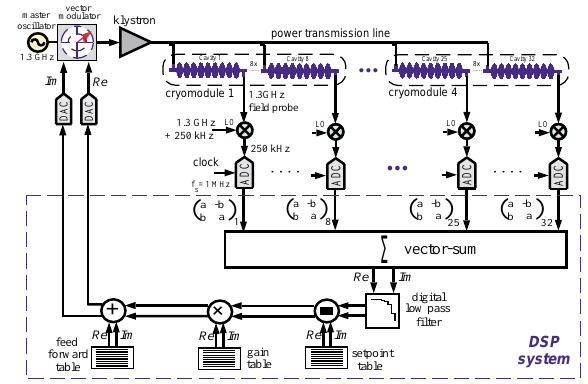
FIG. 27. (Color) Schematic of the digital rf control